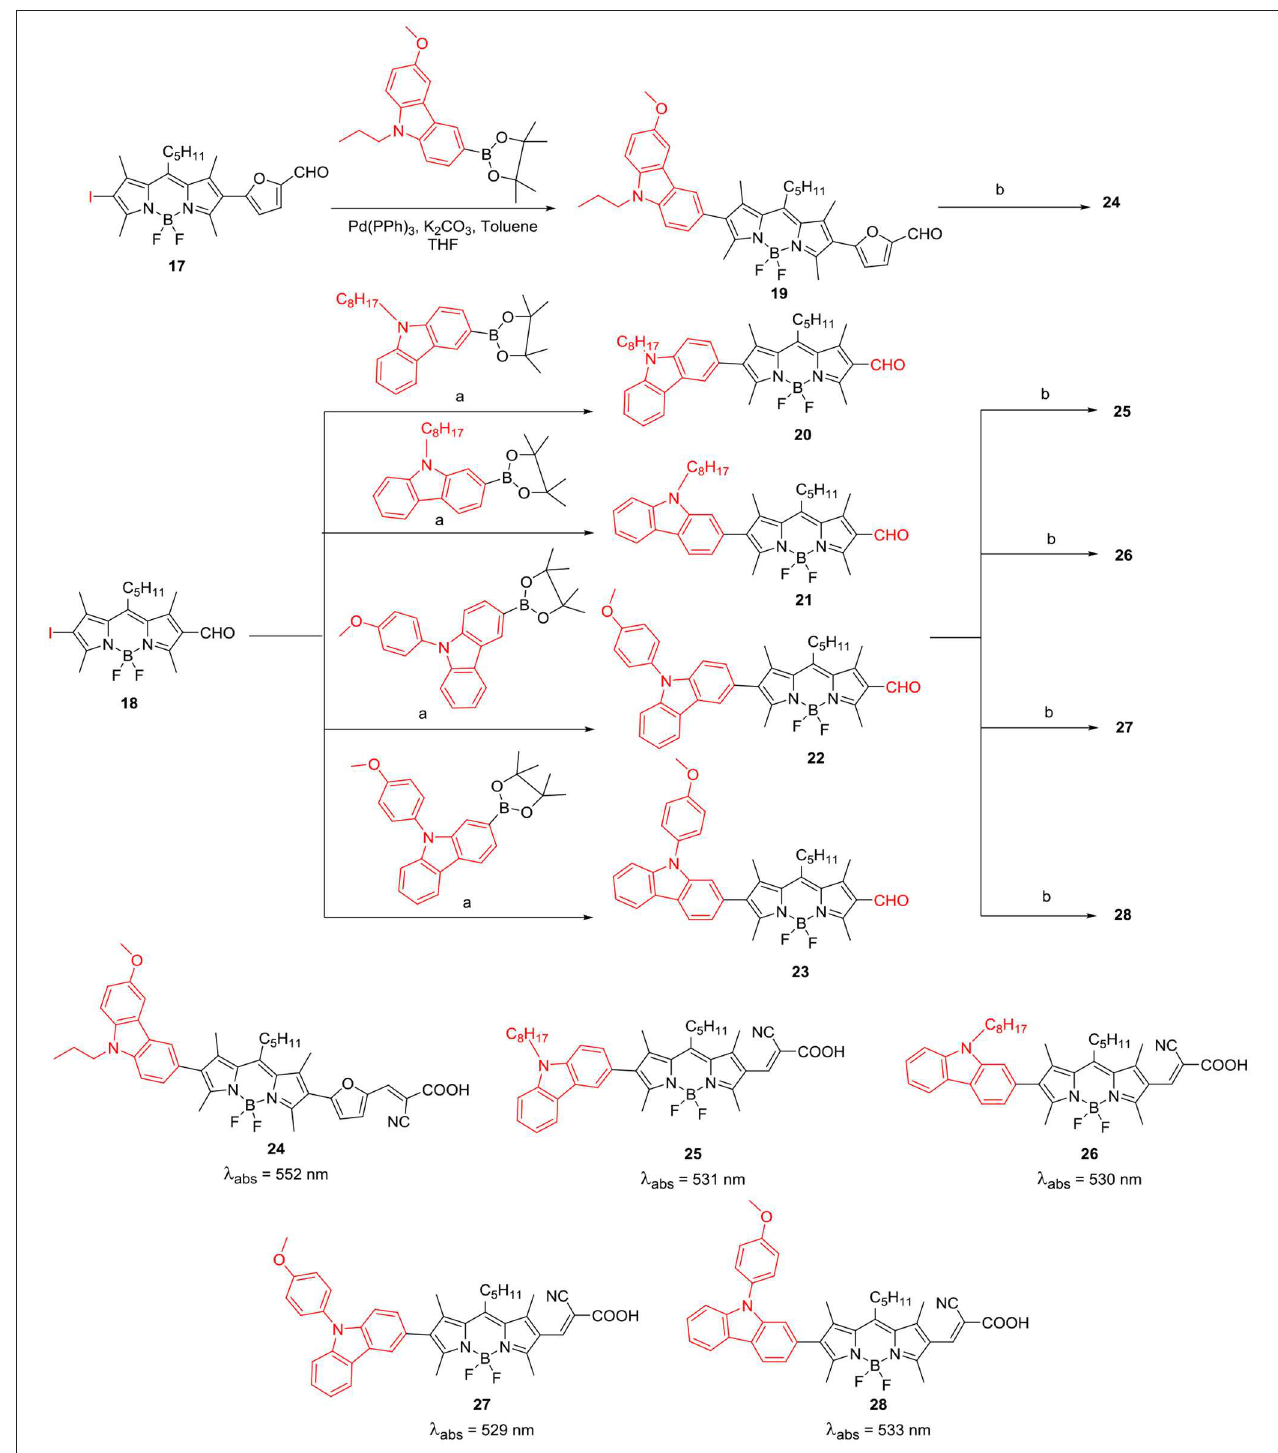
BODIPY dyes showed low photovoltaic performance in